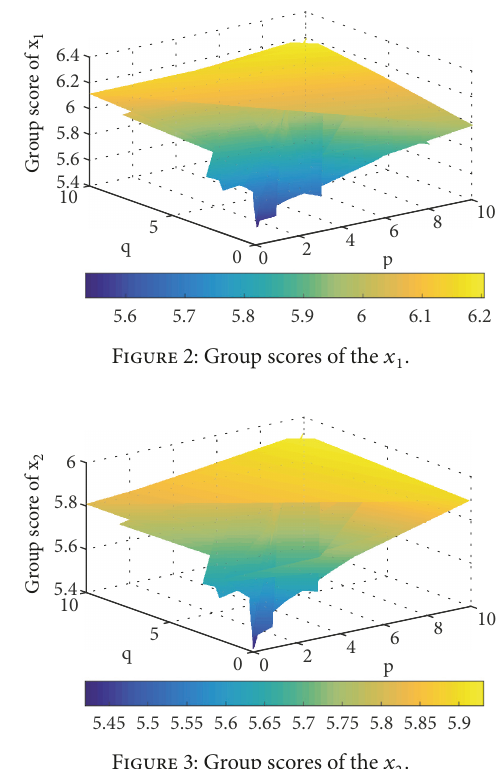
Table 7: Normalize information matrix 𝐻